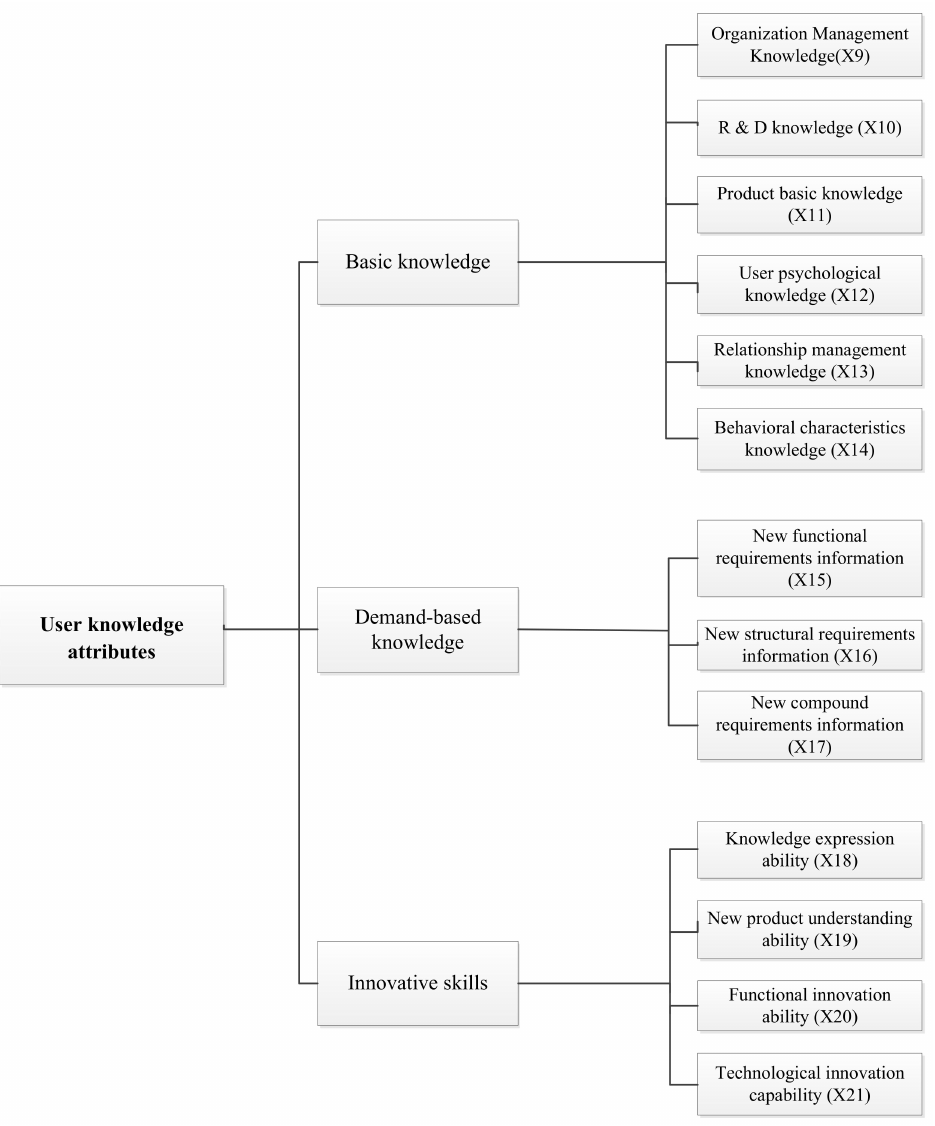
Figure 1. The factors of user knowledge